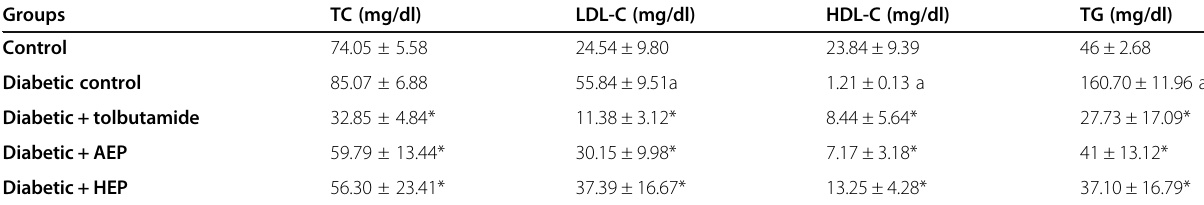
Table 2 Effect of peel extracts of I. wombolu on lipid profile Groups